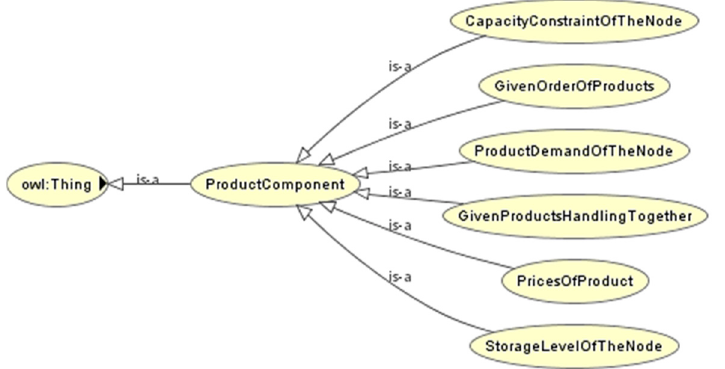
Figure 8. The ProductComponent class.